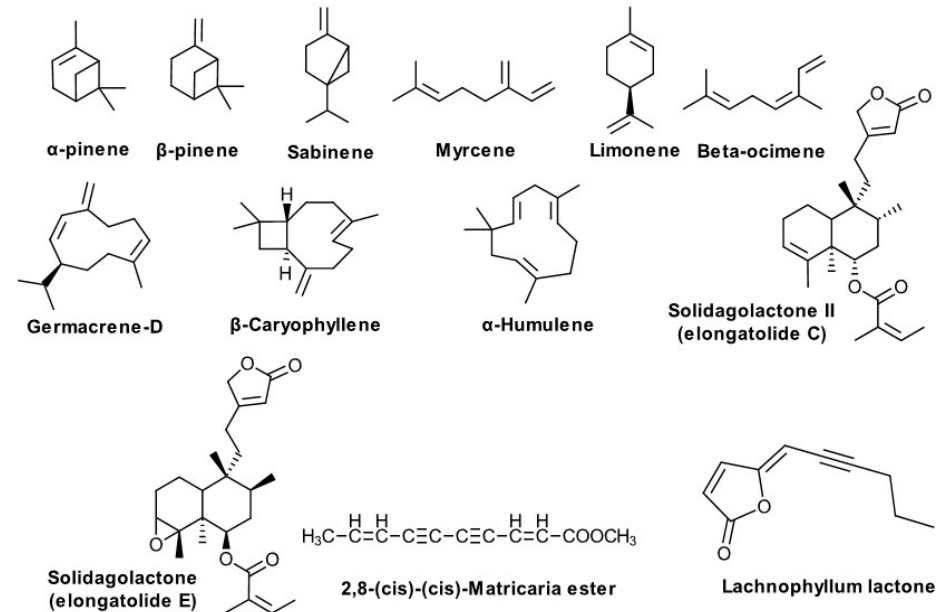
Figure 6. Terpenes from S. virgaurea L.